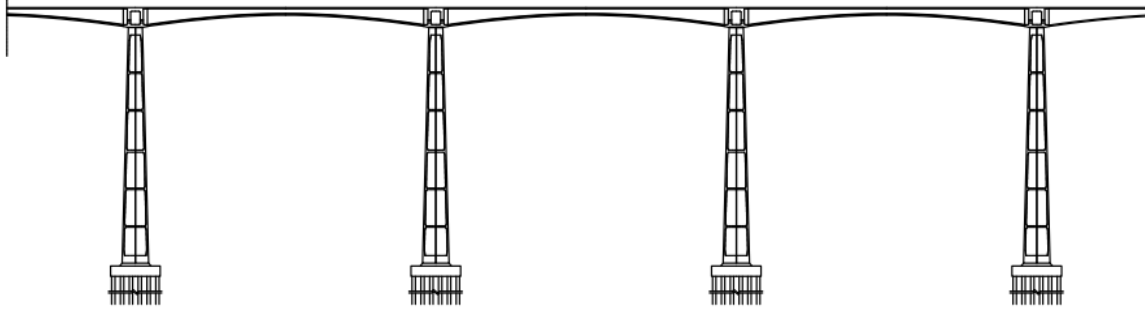
Figure 1. Layout of partial bridge.